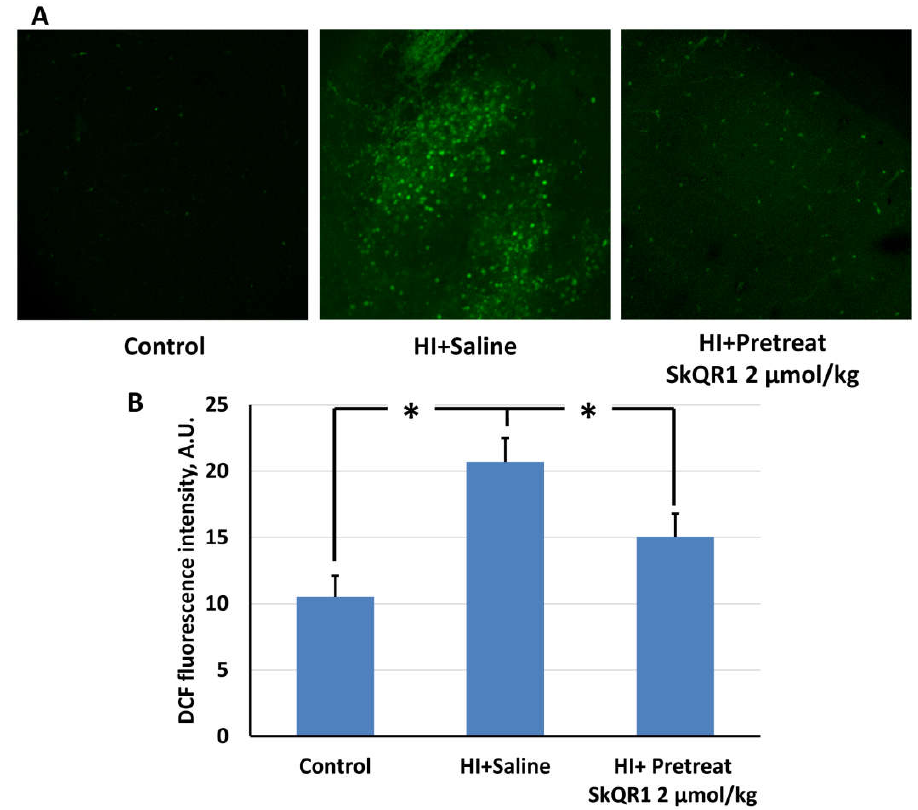
Figure 2. SkQR1 eliminates excessive ROS production in brain after hypoxia–ischemia. ROS levels were evaluated 10 min after reoxygenation by confocal microscopy of vital brain slices loaded with DCF-DA ( A ). Diagram represents quantitation of DCF fluorescence intensity ( B ) as mean ± SEM ( n = 15). Pretreatment with 2 µmol/kg SkQR1 24 h prior to HI results in significantly lower DCF